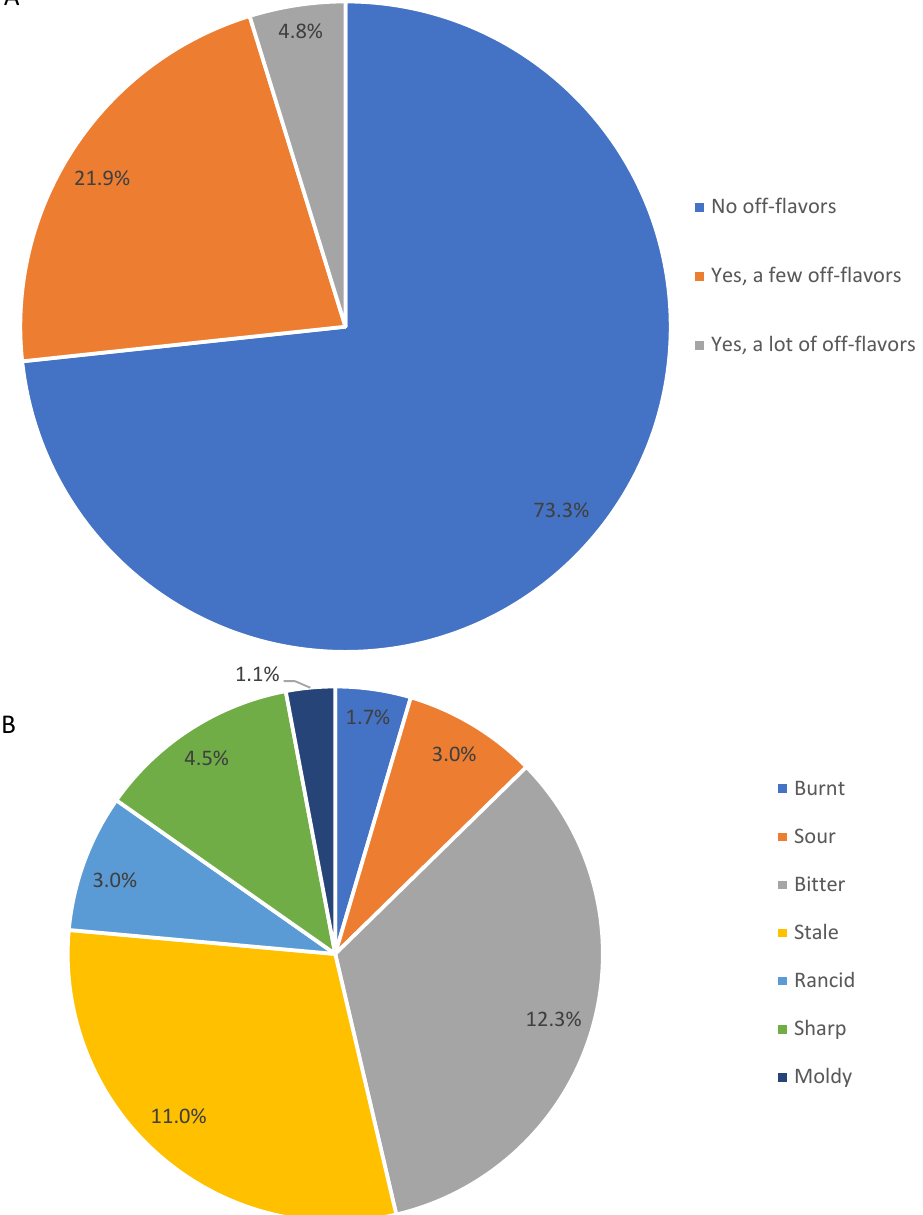
Figure 1. Frequencies (%) of participants ( n = 99) indicating if they perceived any off-flavors with answers of “no”, “yes, a little”, and “yes, a lot” using a single-response question ( A ). Frequencies (%) for each off-flavor attribute calculated by dividing the total selection with the total number of panelists according to a CATA (check-all-that-apply) question ( B ).